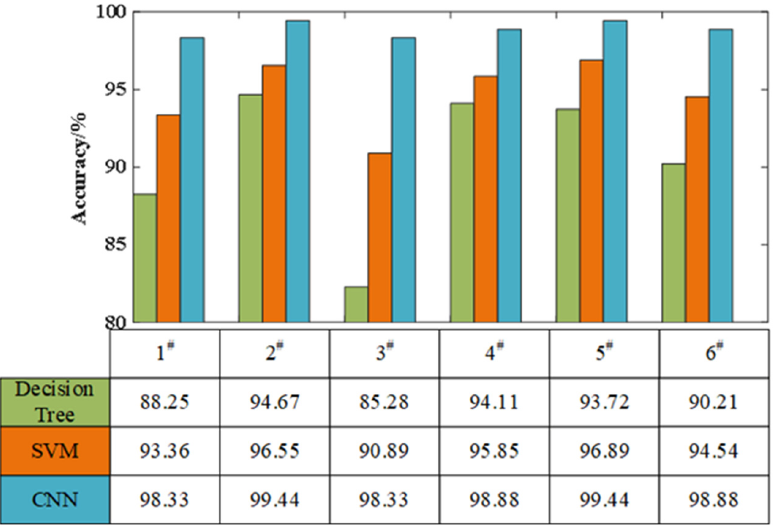
Figure 8. Comparison of recognition accuracy of three models.